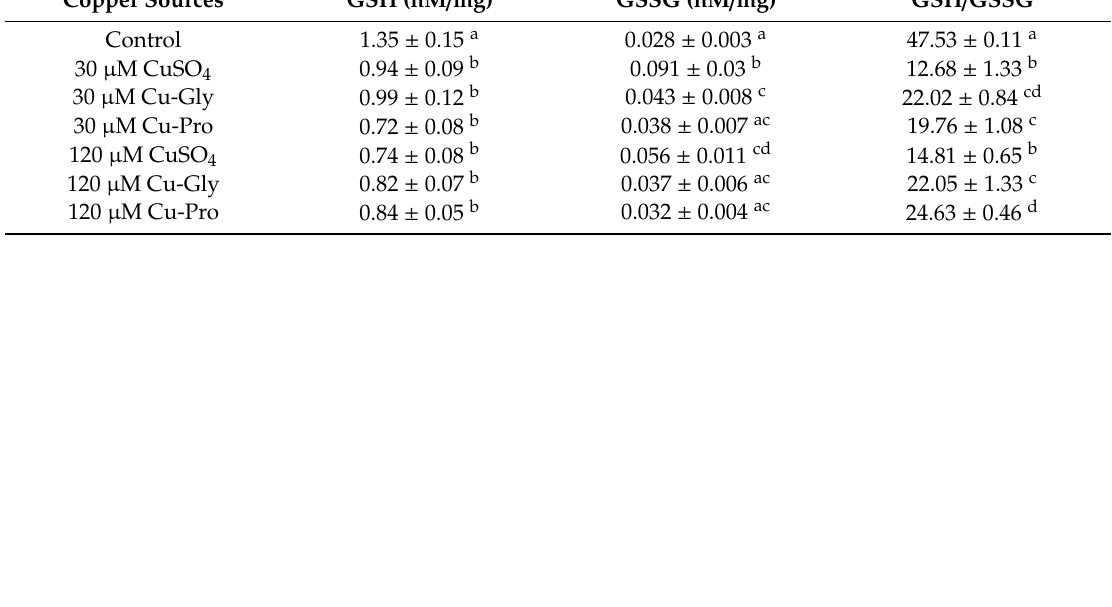
Figure 2. Intracellular copper concentration per 10 6 cells. Cells were treated with CuSO 4 , Cu Glycine (Cu-Gly), and Cu proteinate (Cu-Pro) at the concentrations of 30 and 120 µ M for 10 h. The result was measured by ICP-MS. Data represent mean values ± standard deviation ( n = 3). Significant di ff erences between processing groups are represented by di ff erent lowercase letters ( p < 0.05).